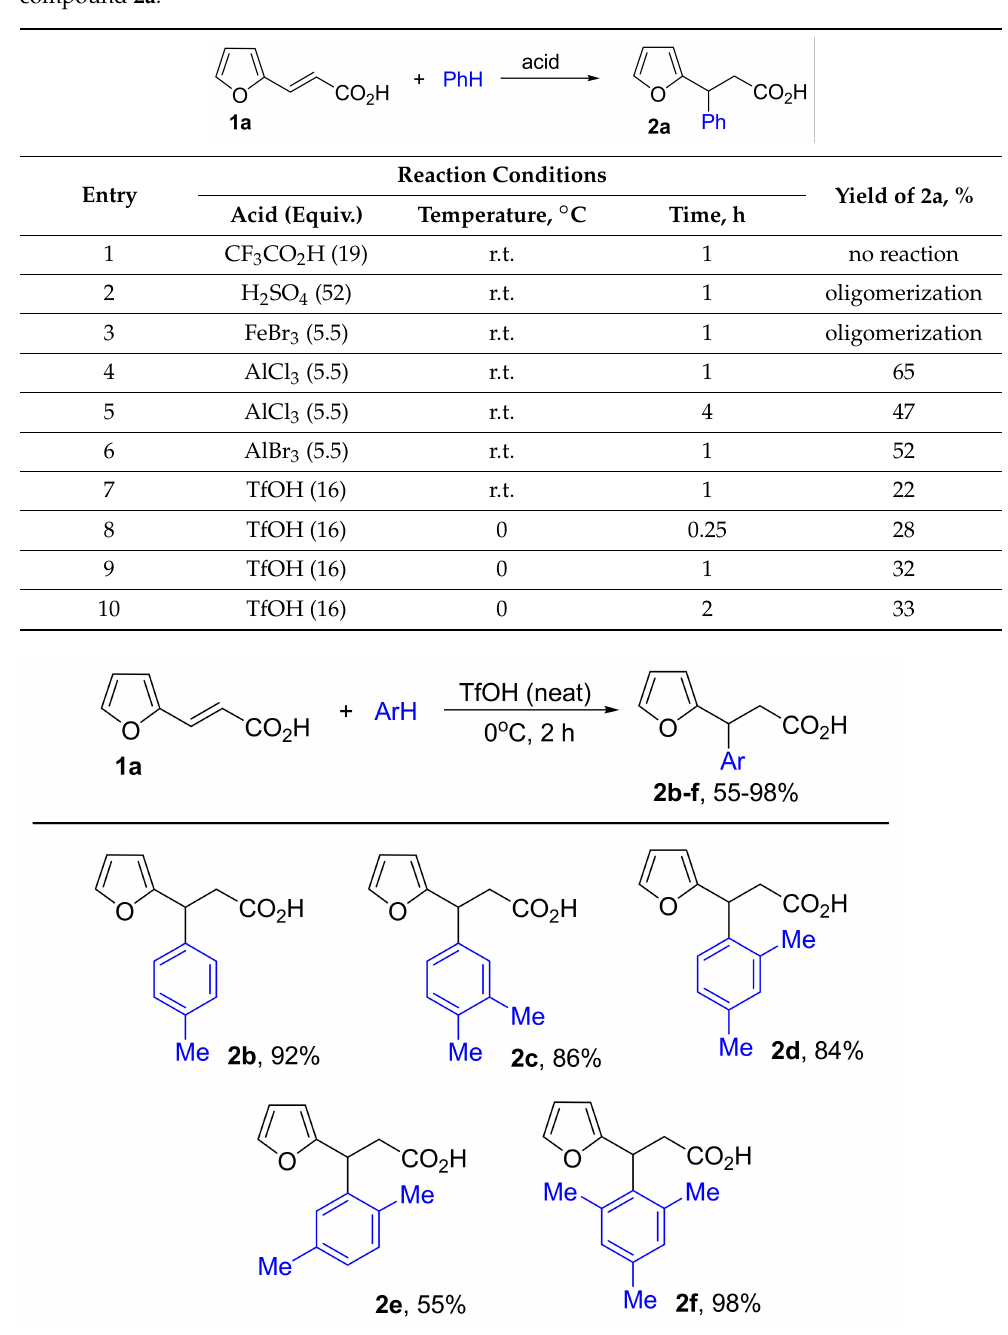
Table 1. Reaction of acid 1a with benzene under the action of Brønsted or Lewis acids leading to compound 2a .